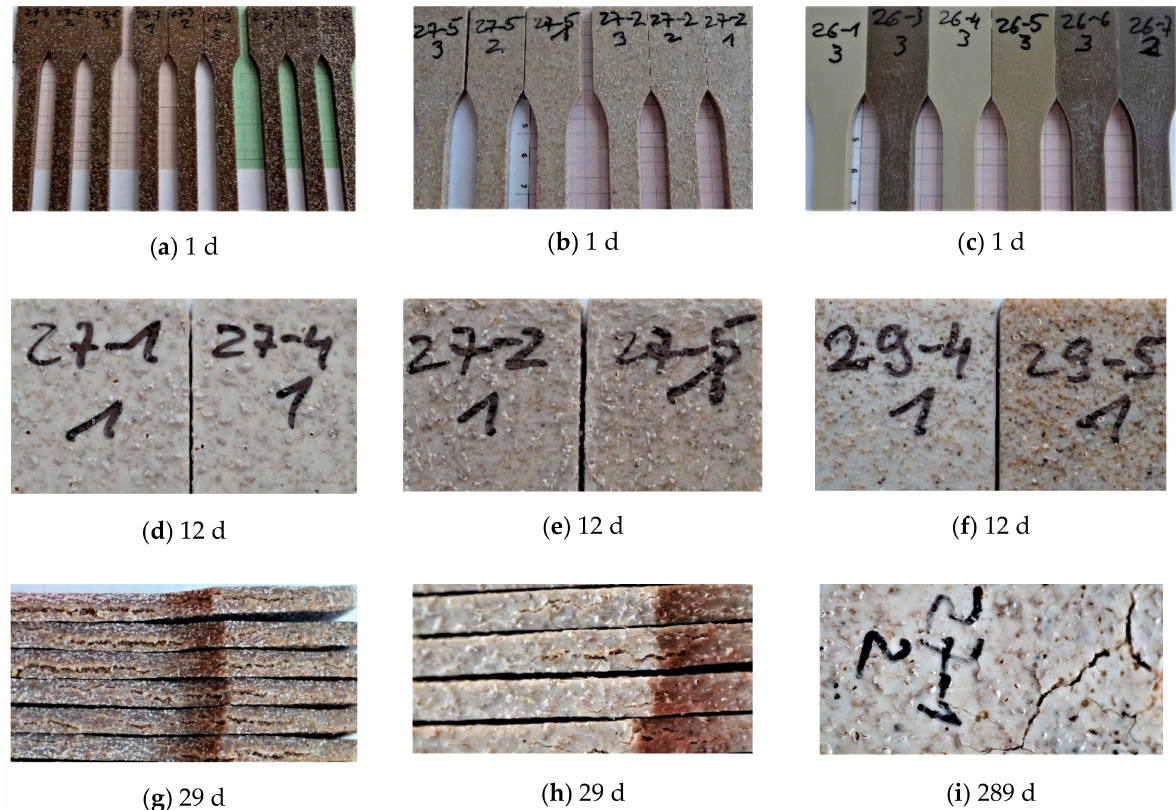
Figure 1. Tensile test bars immersed in water; except ( c ) course SBP type; ( a ) 9:1-c-25-Y coupling agent: Y = 1.5, 1.0 and 0.5 from left to right; ( b ) 9:1-c-16.7-Y, coupling agent: Y = 1.5 and 1.0 from left to right; ( c ) 9:1-f-8.3-1.0 and -1.5 (26-1, 26-4); 9:1-f-16.7-1.5 (26-5); 9:1-f-25-1.0, -1.5 and -0.5 (26-3, 26-6, 26-7; ( d ) 9:1-c-8.3-1.0 and -1.5 (27-1, 27-4); ( e ) 9:1-c-16.7-1.0 and -1.5 (27-2, 27-5); ( f ) 3:4-c-8-1.0 and 3:4-c-16-1.0 (29-4, 29-5); ( g ) the sides of the tensile bars from ( a ) after 29 days, first six from the right; ( h ) the sides of the tensile bars from ( b ) after 29 days, the four in the middle; ( i ) surface of tensile bars from (d) after 289 days).